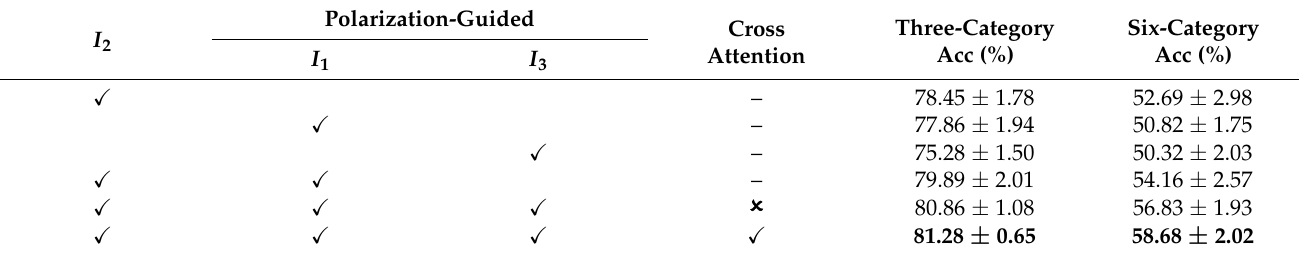
Table 7. Discussion Results on PCCAF.